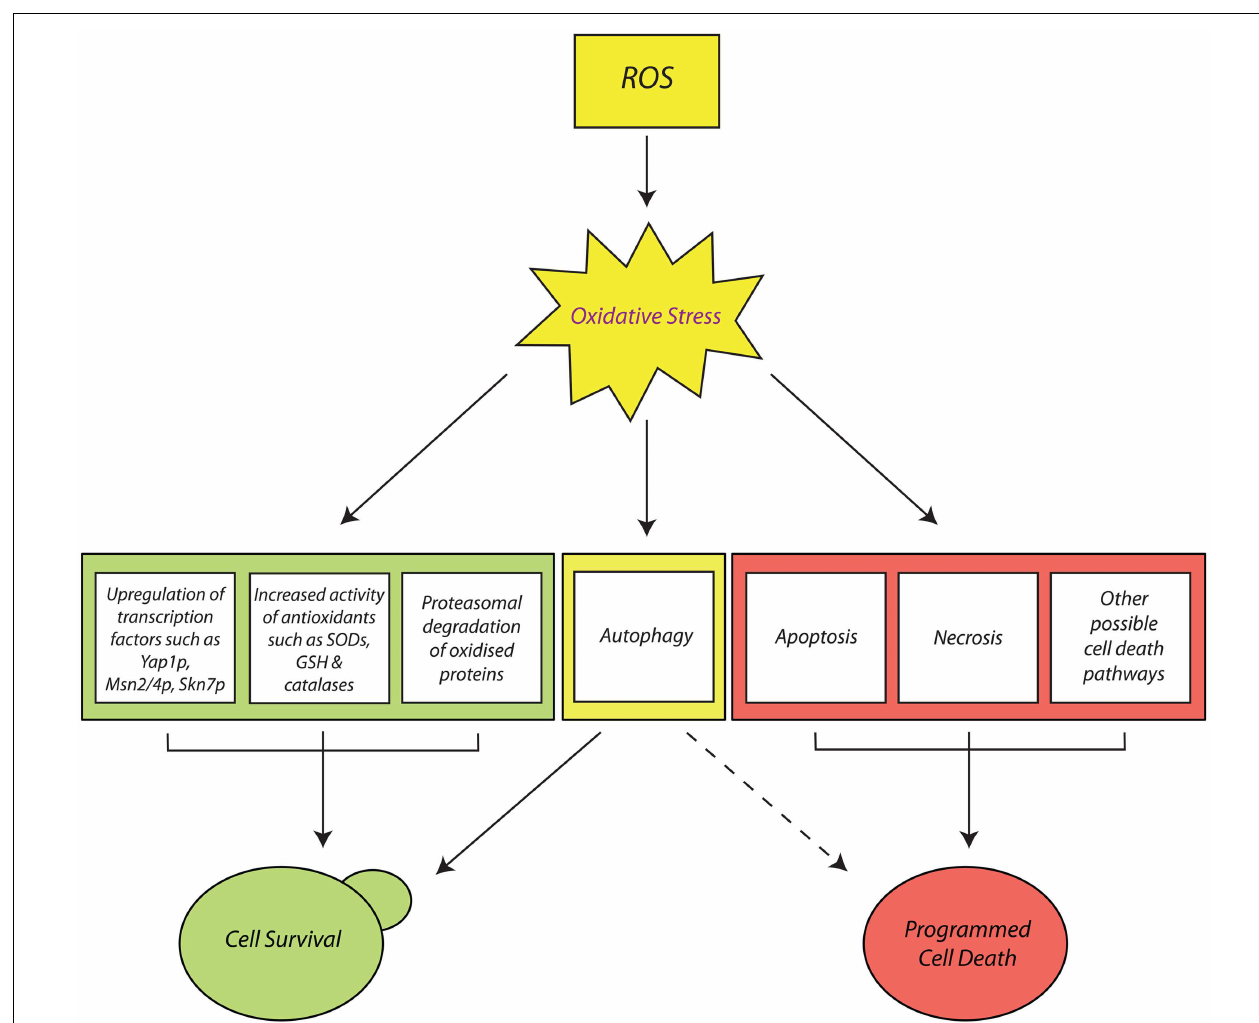
oxidized proteins by the ubiquitin-dependent proteasome system (UPS), FIGURE 1 | Cellular responses to oxidative stress in Saccharomyces help ensure the survival of cells. Additionally, cells can activate cerevisiae . Oxidative stress, induced by the accumulation of reactive oxygen species (ROS) such as O •− , H 2 O 2 , and OH • , can elicit a range of cytoprotective autophagic pathways (bordered in yellow) that remove 2 stress responses in budding yeast cells, that either result in cell survival irreparably oxidized macromolecules or dysfunctional organelles, such as mitochondria. However, an abnormally high degree of autophagy might (shown in green) or cell death (shown in red). Stress signals relayed by also mediate programmed cell death (PCD). Finally, exposure of cells to ROS themselves (such as H 2 O 2 ) can activate transcription factors which upregulate the expression of genes encoding enzymatic (such as severe oxidative insults can elicit lethal response pathways such as apoptosis, necrosis, and possibly other forms of PCD which have yet catalases) and non-enzymatic antioxidants (such as GSH).These response mechanisms, together with the targeted removal of small,